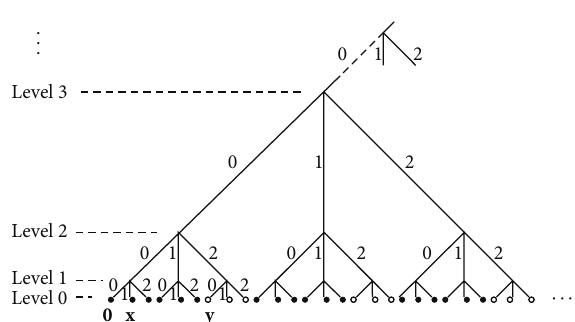
Figure 1: An illustration of bipartite hierarchical lattice (ℓ, 𝛾),Ω 2 (ℓ, 𝛾),𝑑) of order 𝑁 = 3 , ℓ = 2 , and 𝛾 = 2 . Vertices of (Ω 1 𝑁 𝑁 type 1 are represented by solid points while those of type 2 hollow points. The distances between three vertices 0 = (0,0, 0, .. .) ∈ Ω 1 𝑁 , y = (0, 2,0, . ..) ∈ Ω 2 𝑑( 0 , x ) = 1 and x = (1,0, 0, .. .) ∈ Ω 1 𝑁 , and 𝑁 are 𝑑( 0 , y ) = 𝑑( x , y ) = 2